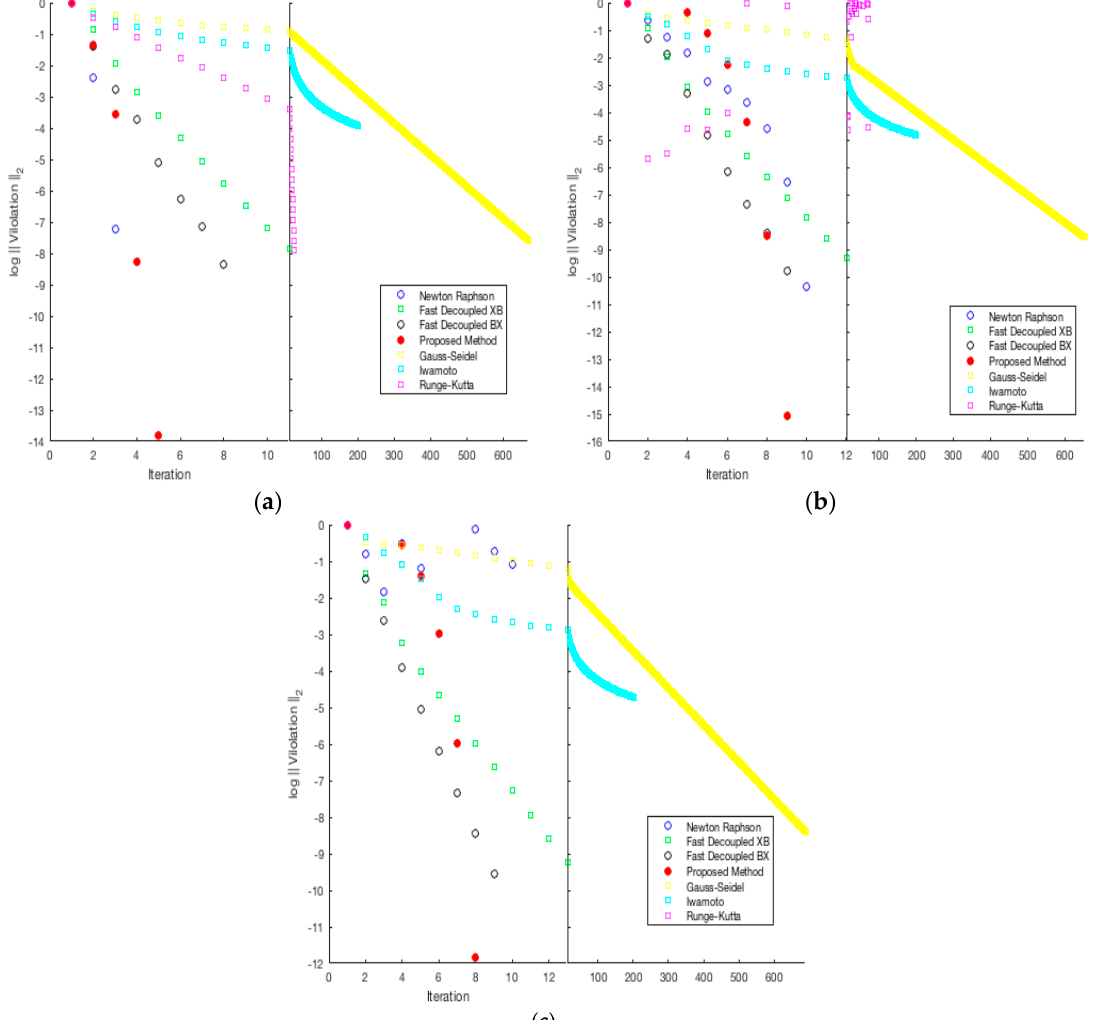
Figure 3. Performances of the Newton–Raphson, fast decoupled power flow, Gauss-Seidel, Runge-Kutta, Iwamoto, and proposed methods to solve power flow problems on an IEEE 30-bus system. Variable ε in the y -axis is the mismatch in power balance or voltage magnitude. ( a ) β = 0.0; ( b ) β = 0.2; ( c ) β = 0.3 in v 0 = (1 T 0 T ) T + β (0 T 1 T ) T .